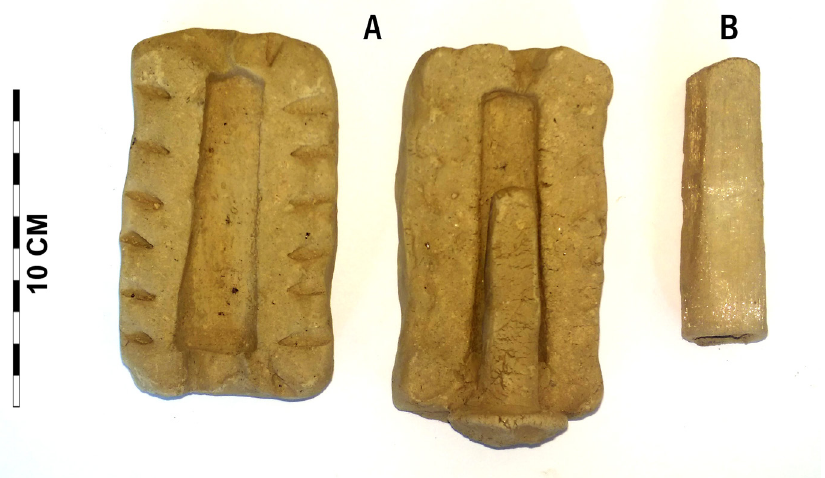
Figure 5. 3D print of a hammer (B) from the Bronze Age Bishopsland Hoard, Ireland, used as a template to make a cast bronze replica in a three-part clay-based mould (A) (Photography, model and experiment by B. Molloy). The use of physically printed models is admittedly limited as a tool for primary research, because of the very different material properties of the original and print media. However, this is not always the case and in our recent experimental project, a SfM model of a Bronze Age lamp from the site of Gradište Idjoš in Serbia was 3D printed (Figure 6). This was coated inside with a thin layer of refractory material, bringing it up to the correct weight and oil-proofing it. With oil and a wick placed within this, the object was used for testing. A ceramic replica was also made for a more conventional approach to this testing, but the results of these tests were comparable. Though this was less of an ideal use of prints for experimental work than the casting templates above, the potential for making and using highly accurate functional replicas that have performance qualities suited to testing particular problems remains to be explored in detail.